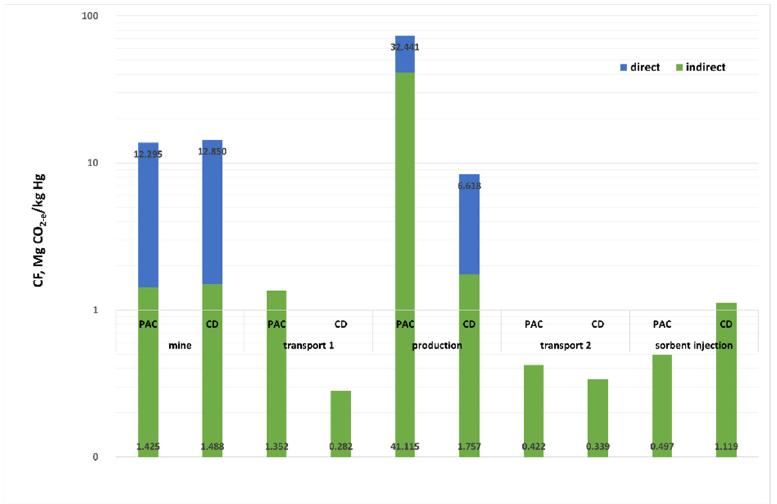
Figure 4. CF of the process of removing 1 kg of mercury from the flue gas over an assumed life cycle. Converting the CF value per kg of Hg removed from the flue gas with PAC and CD results in about four times the CF value for PAC. These values are 89.548 Mg CO 2-e for PAC and 24.452 Mg CO 2-e for CD.